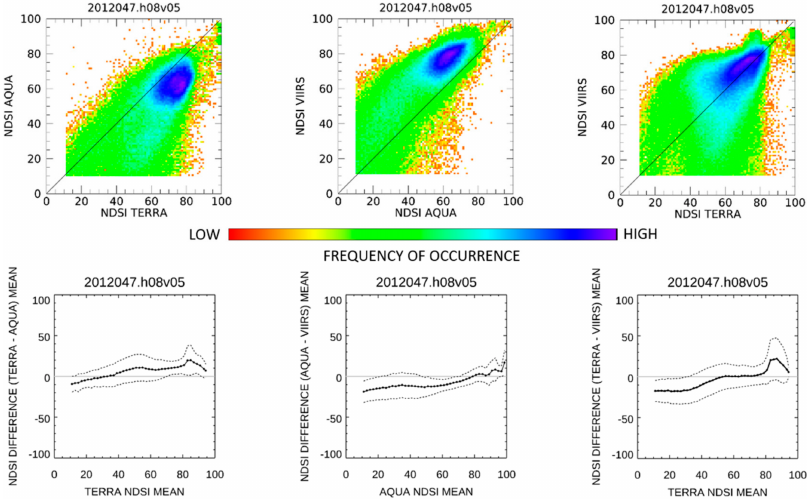
Figure 8. Cross-comparisons of 16 February 2012 for tile h08v05. MOD10A1 to MYD10A1 ( left ), MYD10A1 to VNP10A1 ( center ) and MOD10A1 to VNP10A1 ( right ). 2D histograms of cell-to-cell NDSI_Snow_Cover comparisons in the top row. NDSI_Snow_Cover mean di ff erences in the bottom row; mean is solid line and standard deviation is dashed